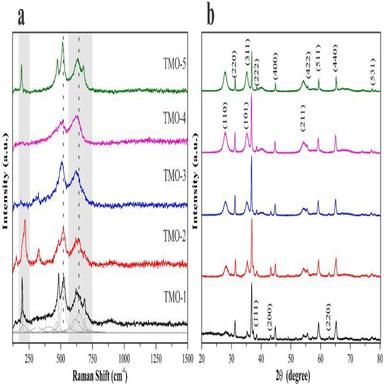
(a) Raman spectra and (b) XRD diffractograms obtained for the as-synthesized TMOs contrasting the different metal fractions.